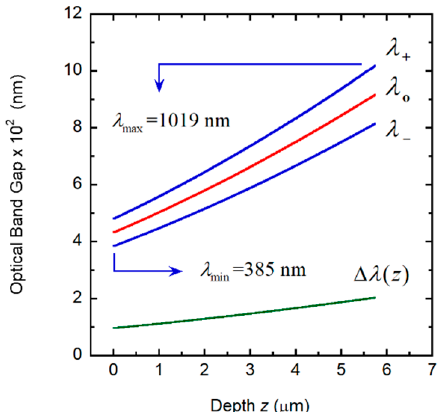
Figure 8. Depth dependence of the photonic band gap ( ∆ λ ( z )), its spectral limits ( λ + ( z ) and λ − ( z )) and central position ( λ o ( z )). The spectral limits of the reflection band ( λ min and λ max ) are also indicated.